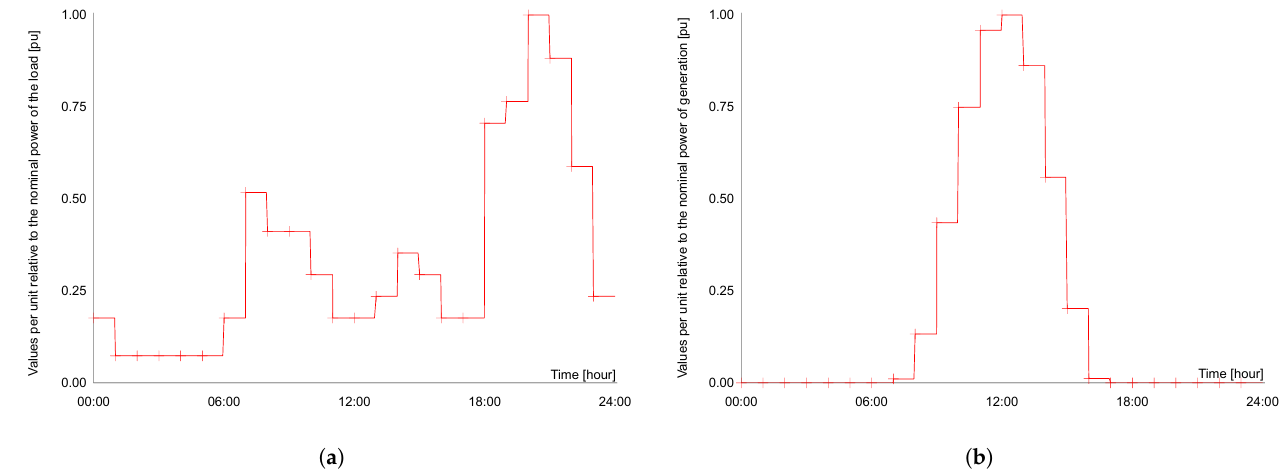
Figure 1. Quasi-dynamic profiles: ( a ) Residential load, ( b ) PV